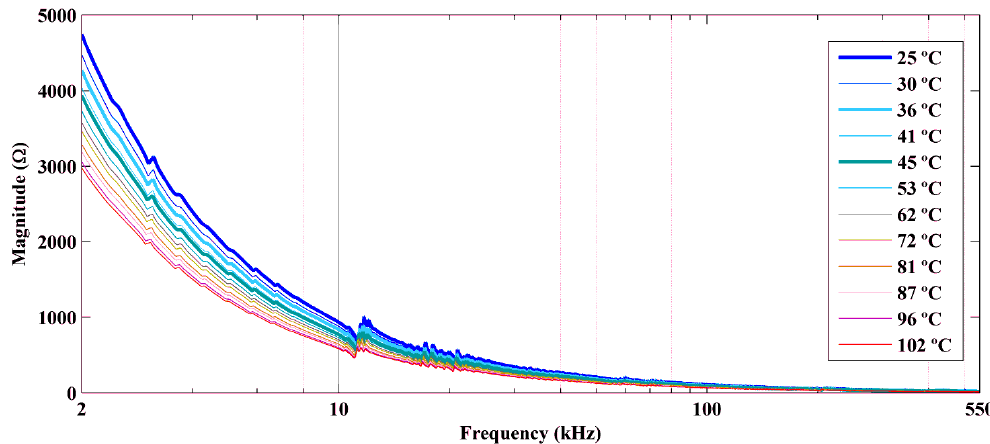
Figure 9. Magnitude of the impedance signatures obtained at different temperatures.